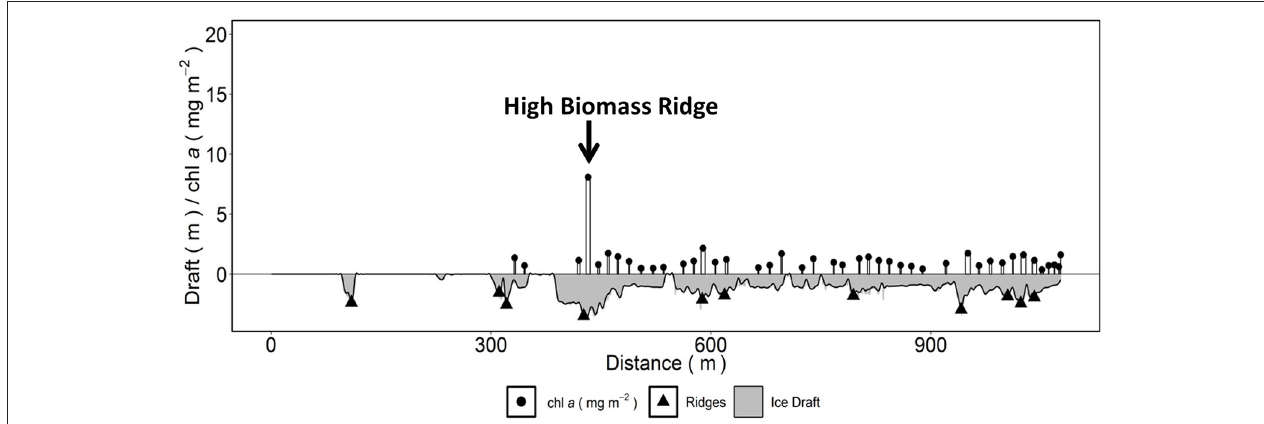
FIGURE 7 | Horizontal profile of Surface and Under-Ice Trawl (SUIT) station 223 showing sea ice draft, identified ridges and chlorophyll a biomass derived from spectral radiation measurements. Highlighted is an identified high chlorophyll a biomass sea ice ridge. Width of the white bars corresponds to the relative along-track footprint of spectral radiation measurements. The black line corresponds to the smoothed sea ice draft curve used for the ridge identification procedure and was determined from the ice draft measurements (gray shaded area).